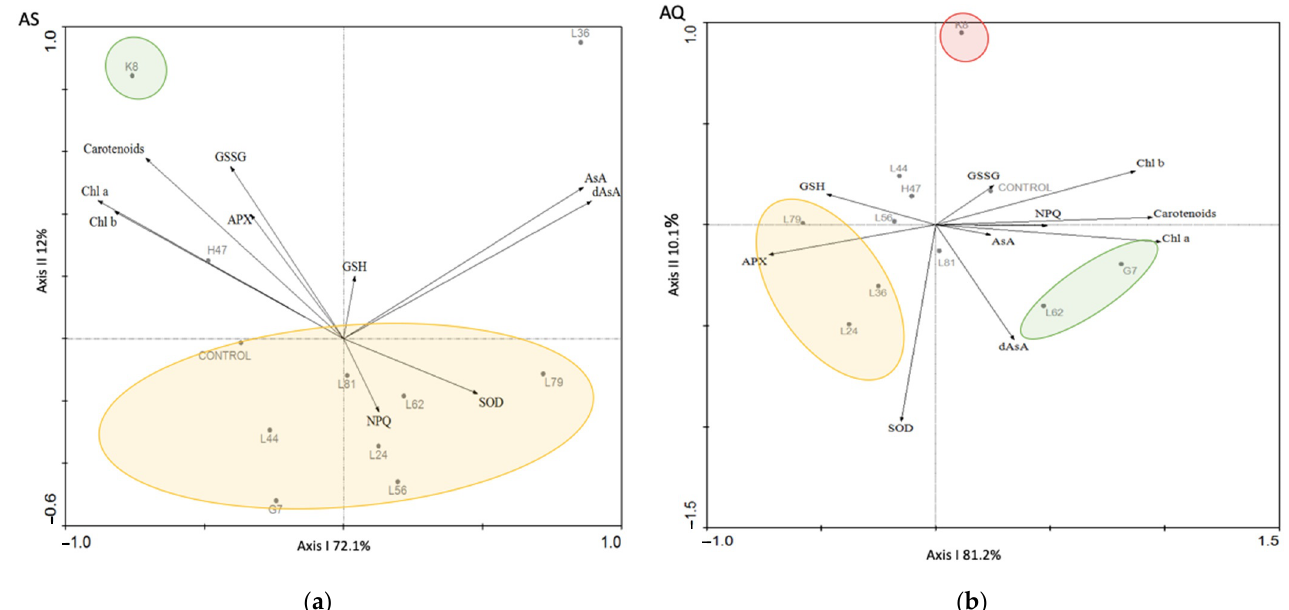
Figure 9. Malondialdehyde concentration (µmol g − 1 FW), in ( a ) AS and ( b ) AQ leaves of plants inoculated with the 10 PGPB and non-inoculated controls. Values are the average ± SE (n = 3). Asterisks (*) indicate significant differences with the controls according to t student ( p < 0.05).